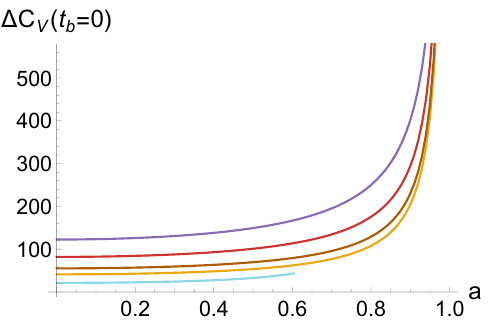
Figure 14 . ∆ C V ( t b = 0) as a function of m and a , for G N = ‘ = 1 . From the bottom up m = 1 , 3 , 5 , 10 , 20